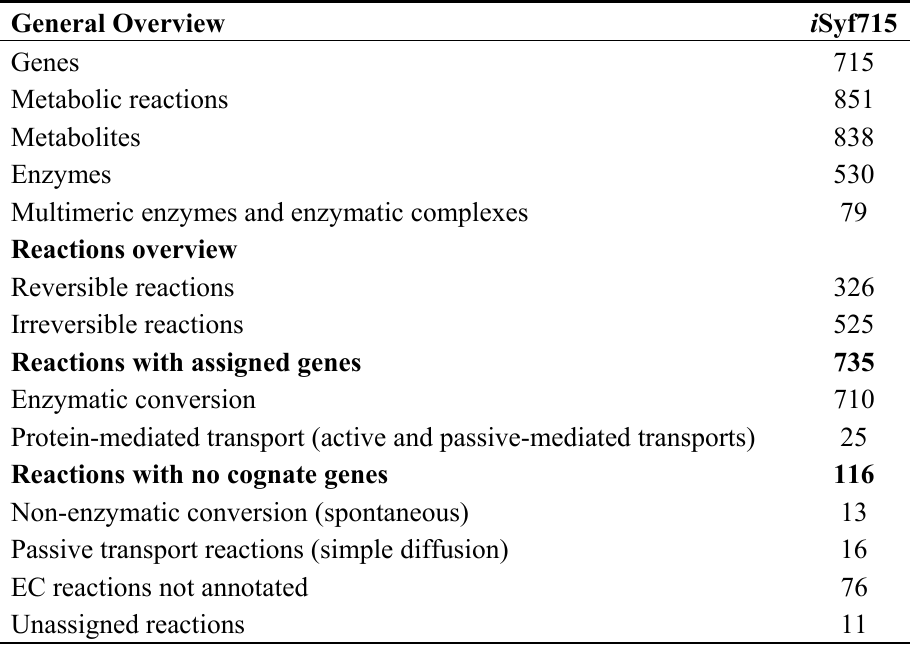
Table 2. Distribution of elements in the database retrieved from Pathways Tools and the final model, i